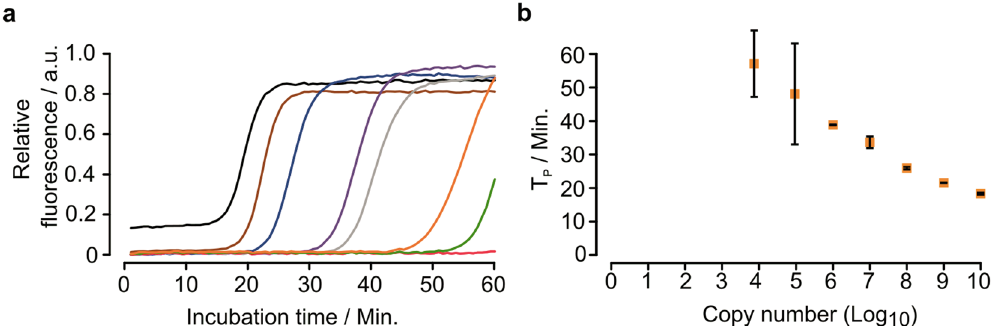
Figure 6. Sensitivity of the HIP-reaction. Detection limit with the LZ-HR primer and the corresponding primer LZF-0 in combination with the primer LZR-653 for the detection of serial diluted genomic E.coli DNA for 60 minutes at 65 °C. The time-to-positivity is directly correlated to the input amount of DNA ranging from 10 4 to 10 10 copies of the E.coli fragment. The coefficient of determination R 2 = 0.98. The experiments were carried out in triplicate and standard error bars are shown in the